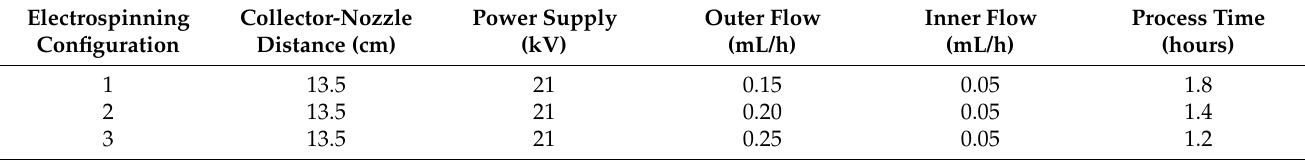
Table 2. Electrospinning fabrication parameters of the three different configurations for the fabrication of irinotecan-loaded